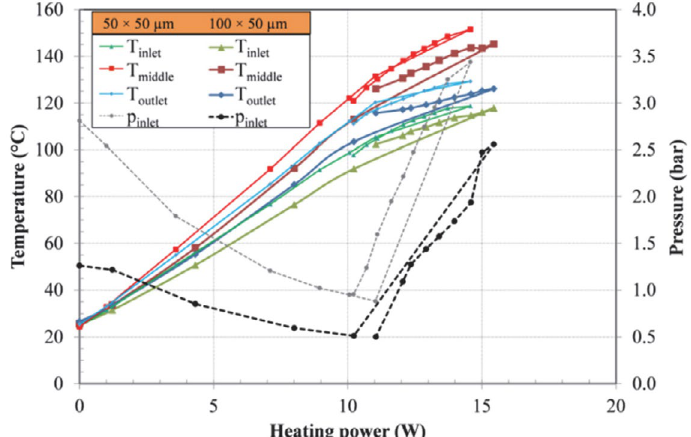
Figure 7. Comparison of temperatures and pressures in a single 50 × 50 µm and 100 × 50 µm microchannel at the same volumetric flow of 0.2 ml/